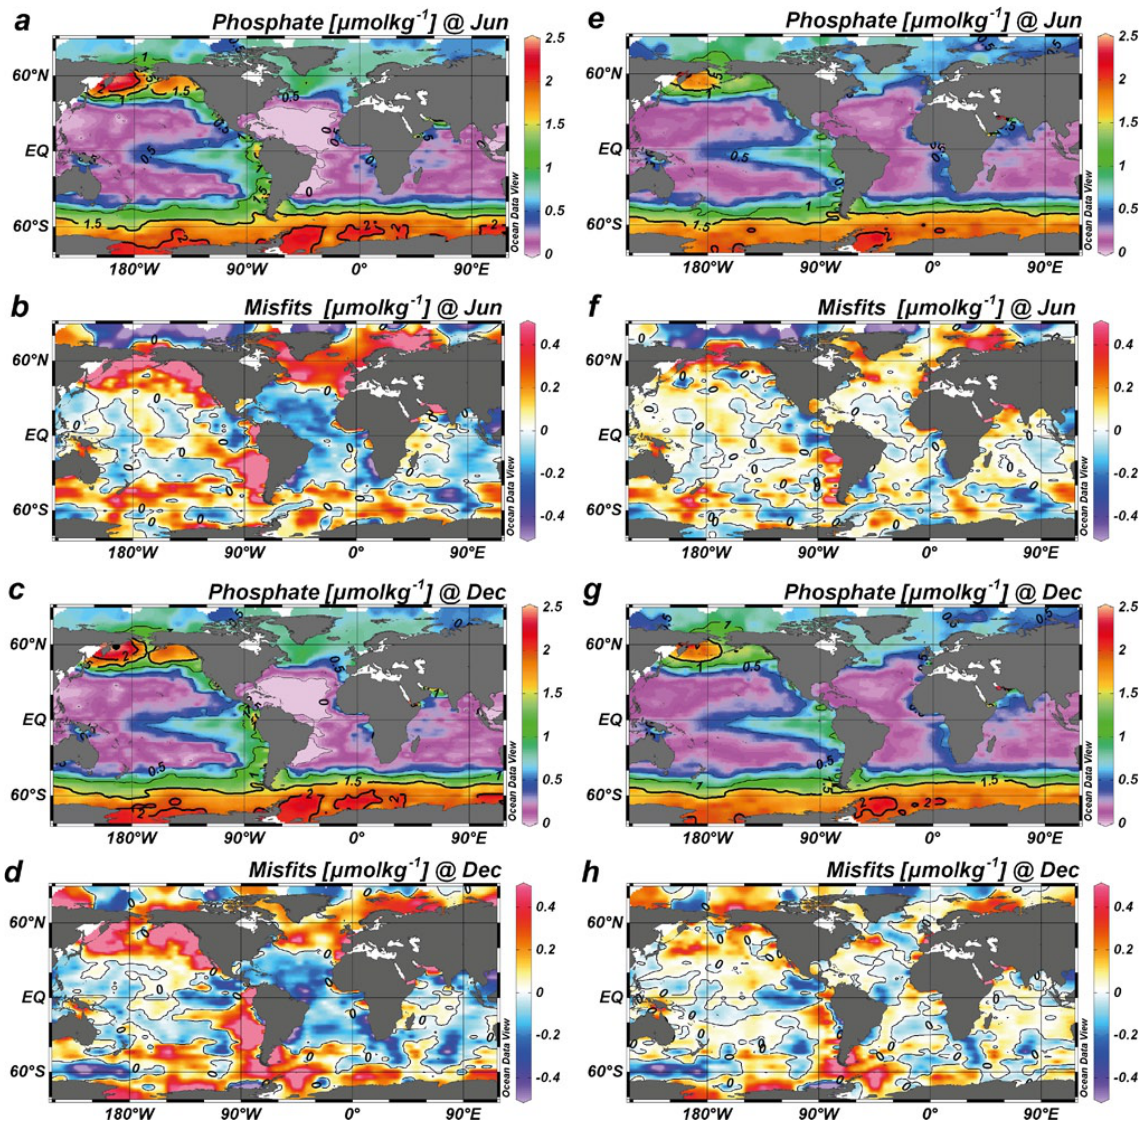
Fig. 7. Model-simulated surface water phosphate and model–data misfits for June and December. The left-hand column (a–d) is for Exp A, and the right-hand column (e–h) for Exp